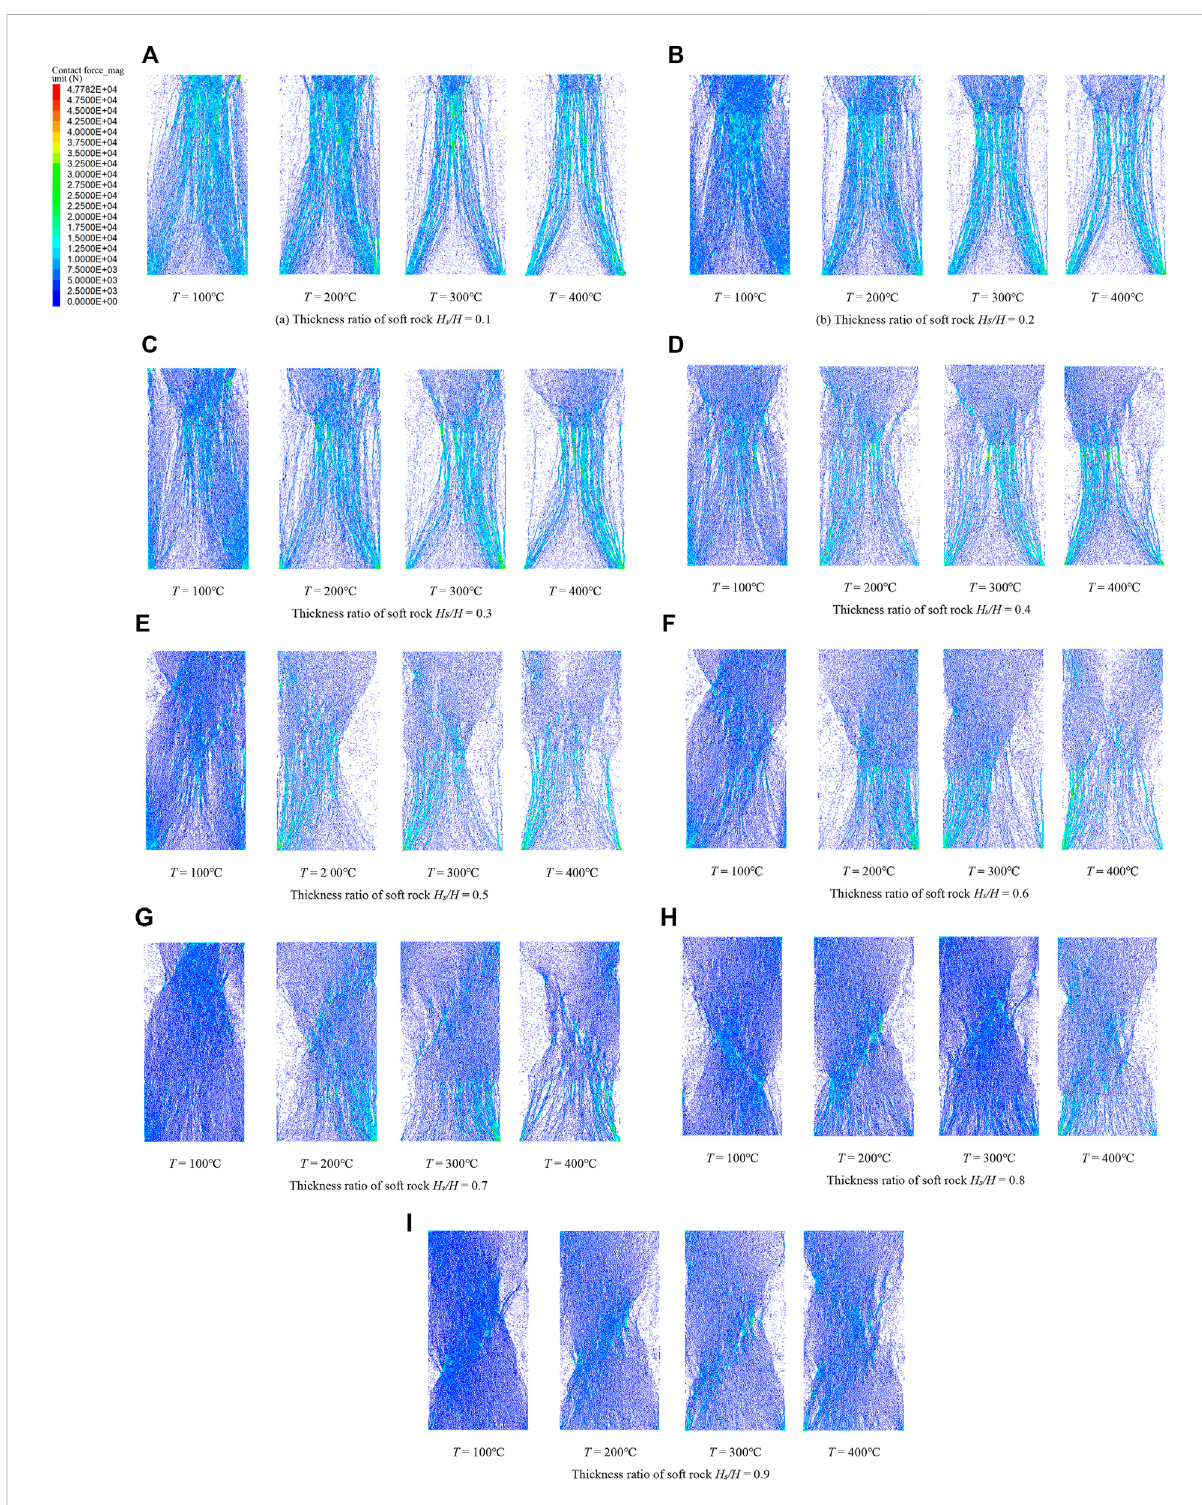
FIGURE 9 Contact force chain after specimen failure under different working